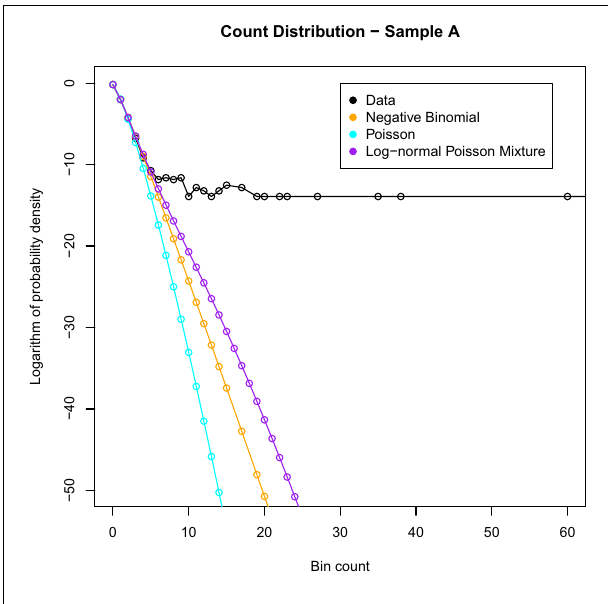
FIGURE 1 | Illustrating the best fits of the commonly used distributions to the count data for sample A. Note that none of these distributions can model adequately the heavy tail of large bin